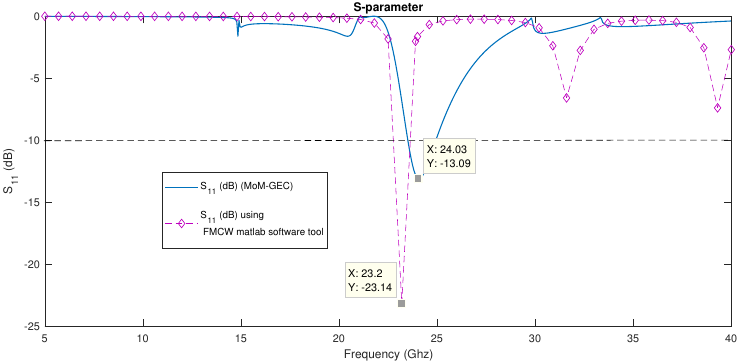
Figure 5. S 11 -parameter (dB) variation against frequency band around 24 GHz: a comparison between the MoM-GEC and a MATLAB tool (see references